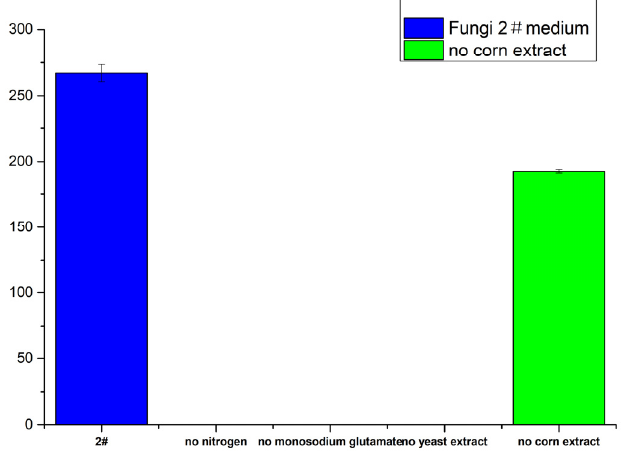
Figure 12. The yield of meleagrin under different nitrogen sources. ＃ represents the number of the culture medium.